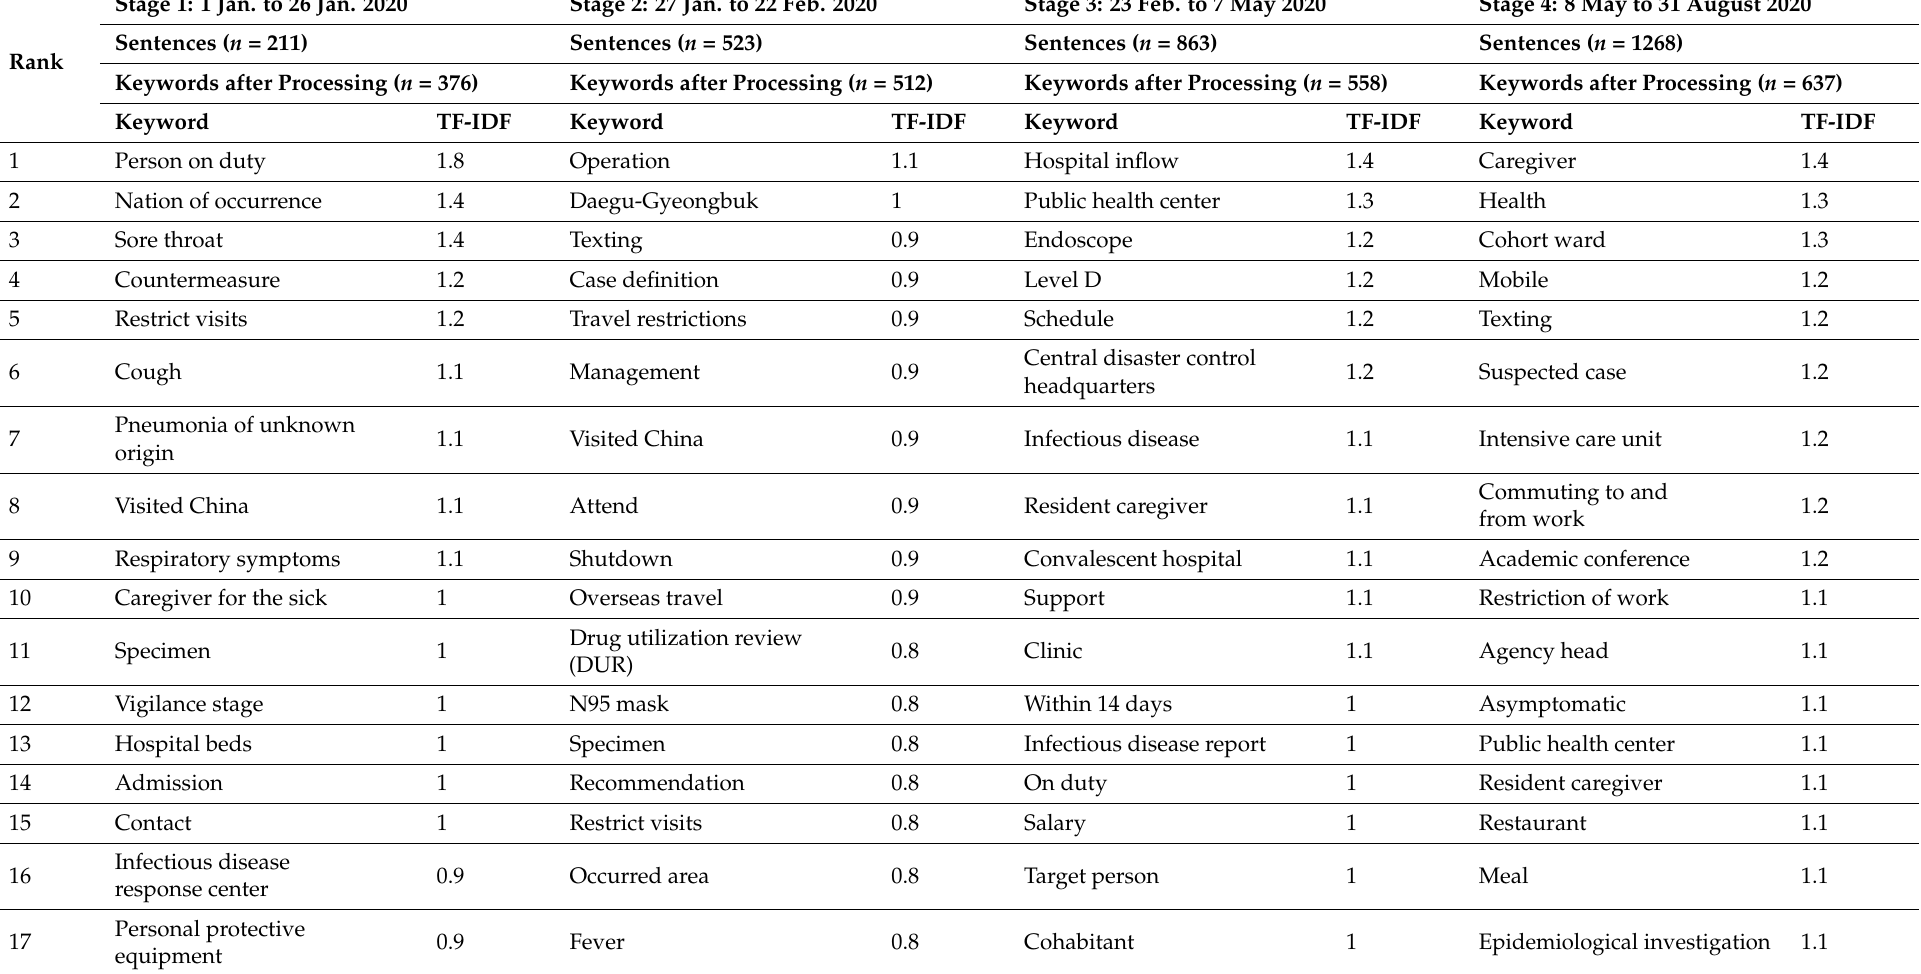
Table 1. Top 30 keywords extracted from electronic notices over